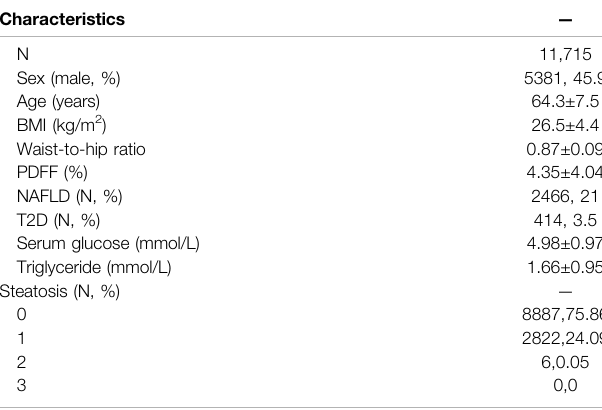
TABLE 1 | Baseline characteristics of the study